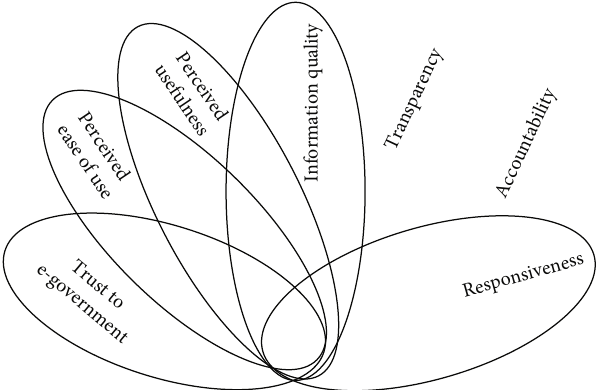
Figure 7: Path 4 contributes to low e-government participation (LEP) ( consistency = 0 : 982 and coverage = 0 : 800 ). Note: the dotted ellipse represents the absence of the condition. If no ellipse displayed, it belongs to the “ do not care ”